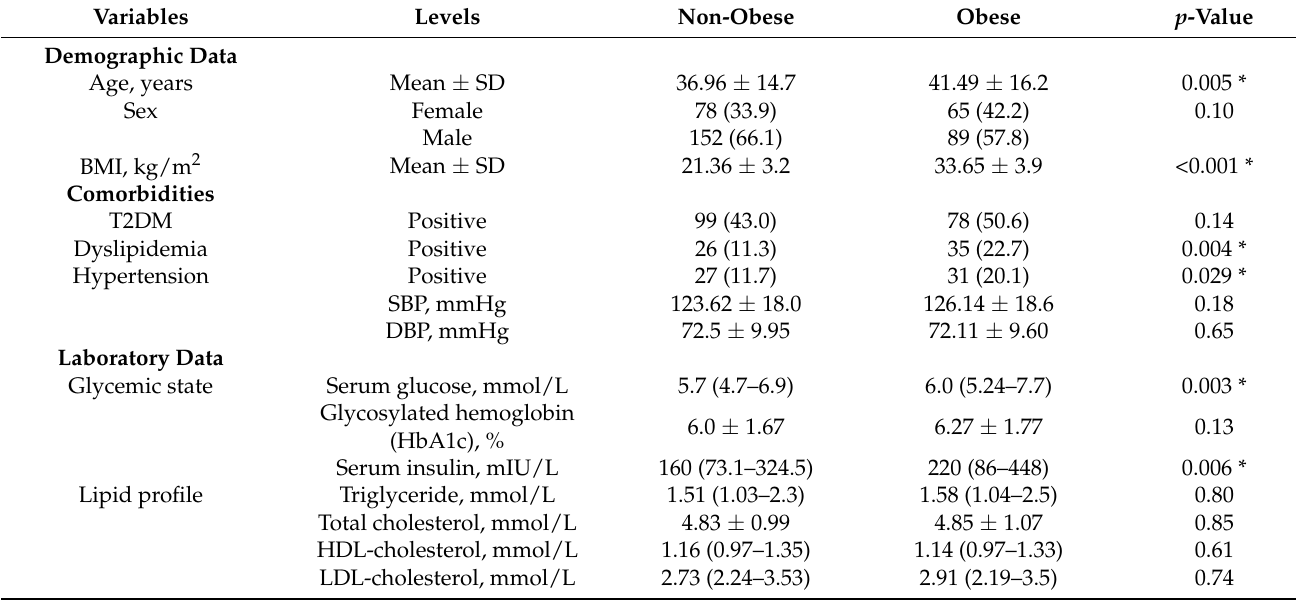
Table 1. Clinical and biochemical characteristics of the study population.